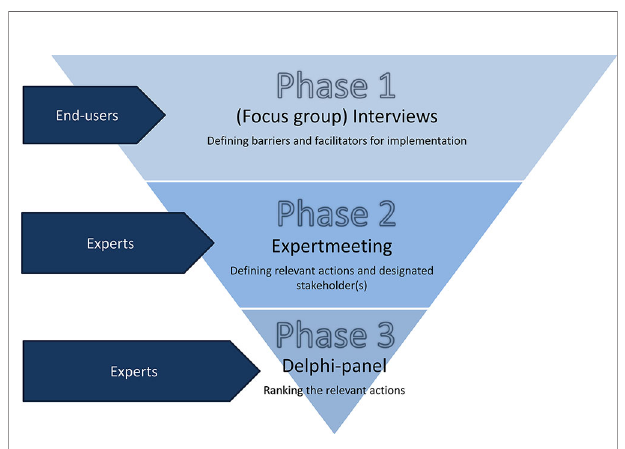
FIGURE 2 | Methods and aim of the three phases of